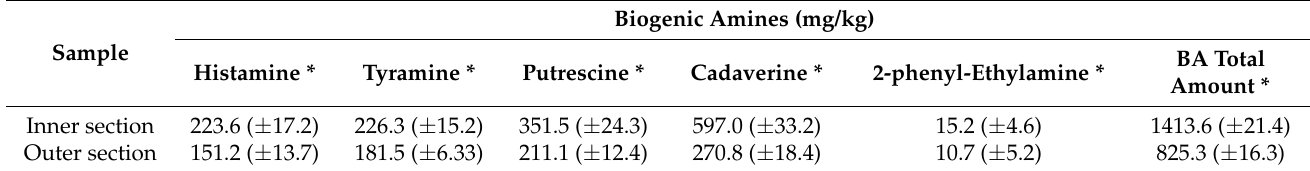
Table 3. Biogenic amine content (expressed as mg/kg) of the ripened sausages in the inner and in the outer section. Results are the mean of three independent repetitions. For each compound significant differences between samples according to Mann-Whitney test are indicated by the presence of an